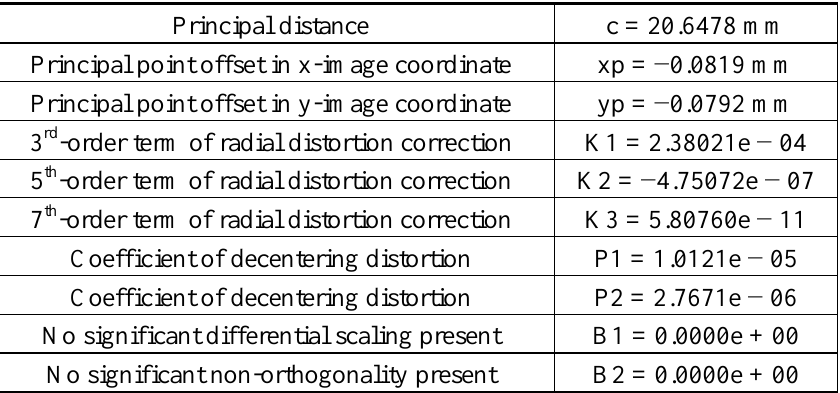
Table 3. IOP of EOS 5D Mark